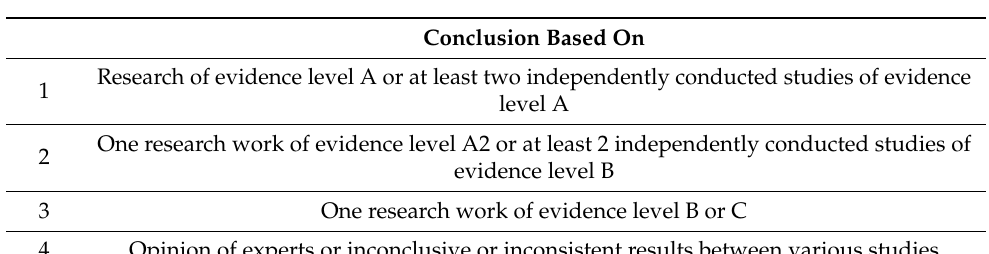
Table 6. Strength of